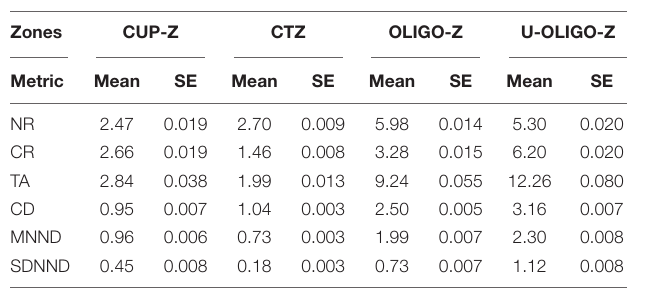
TABLE 5 | Layman metrics (mean ± SE) estimated by a Bayesian approach from the area defined by δ 15 N and δ 13 C of mesozooplankton for four study zones (all size-clases combined).